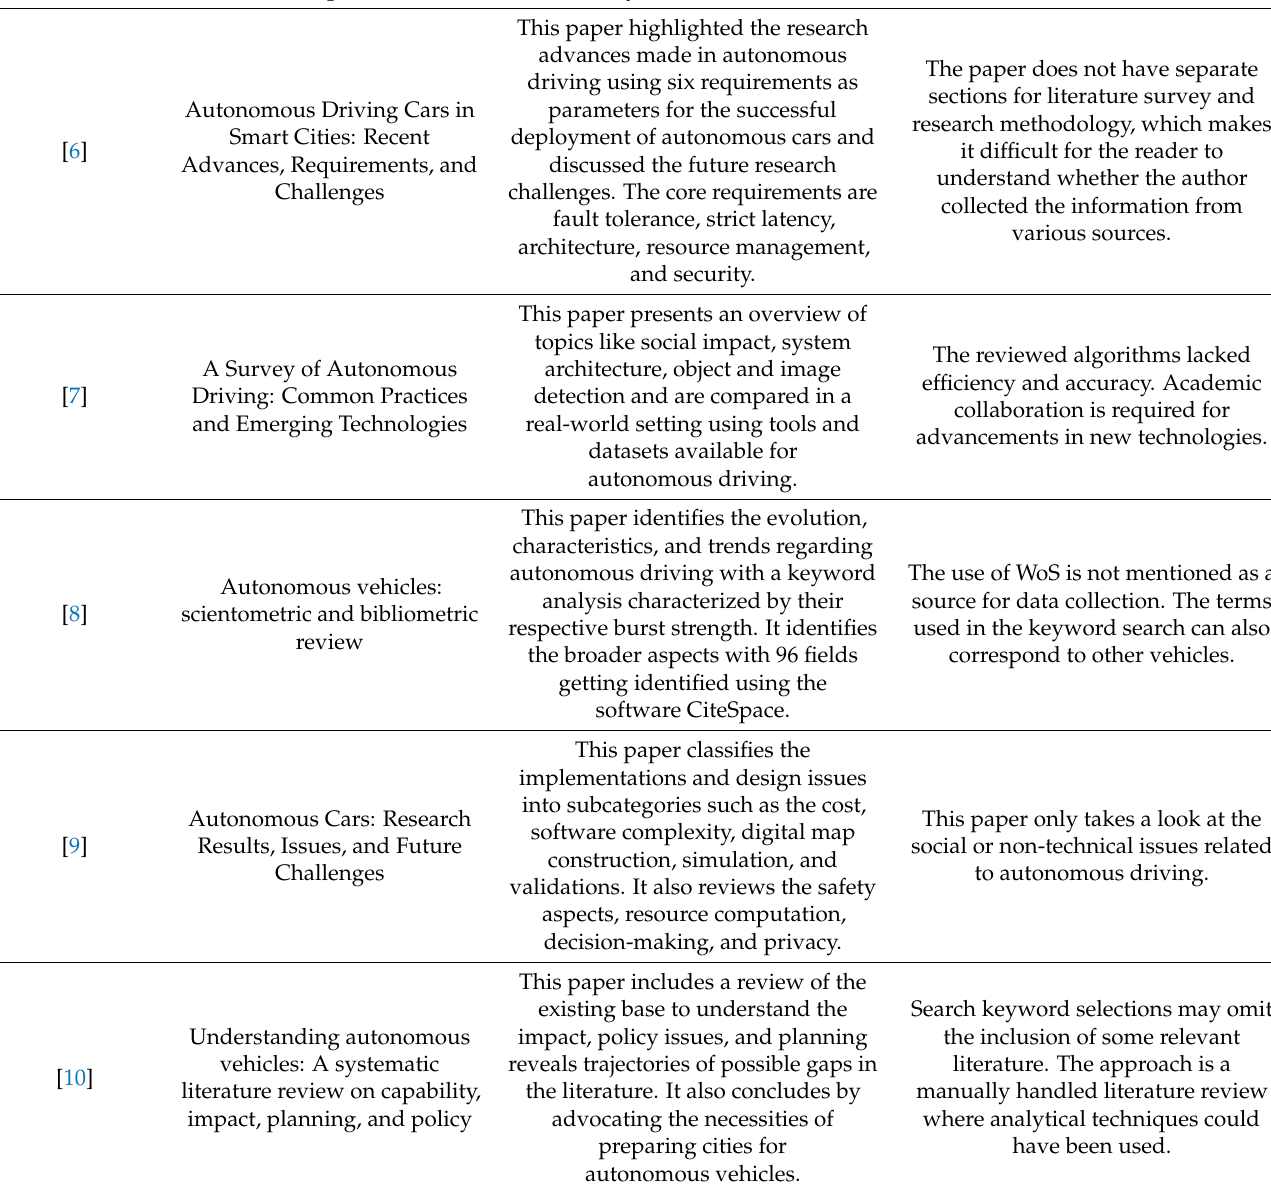
Table 2. Comparison of existing review